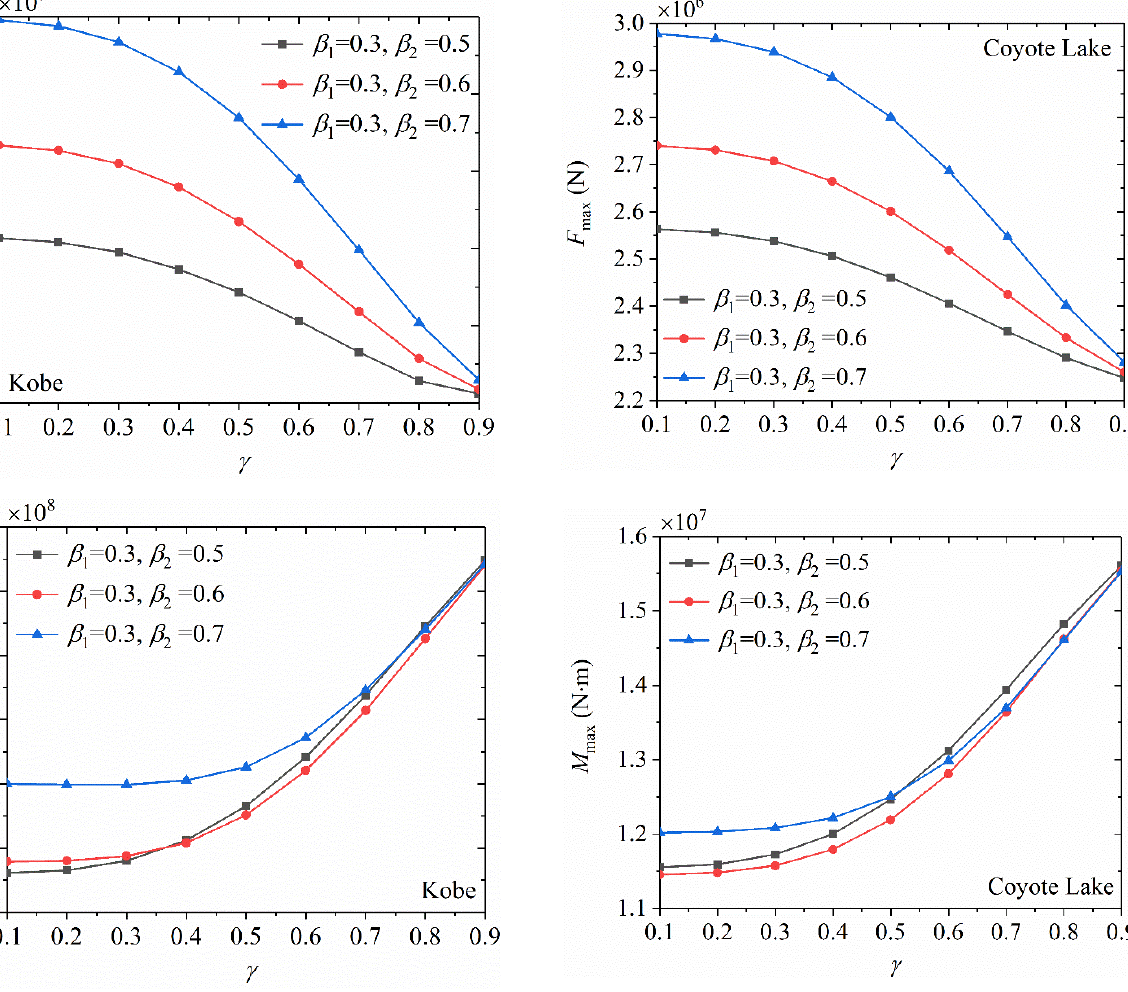
Figure 14. The maximum of the hydrodynamic response for the baffle inner radius γ : ( a ) the shear force F max ; ( b ) the overturning moment M max .